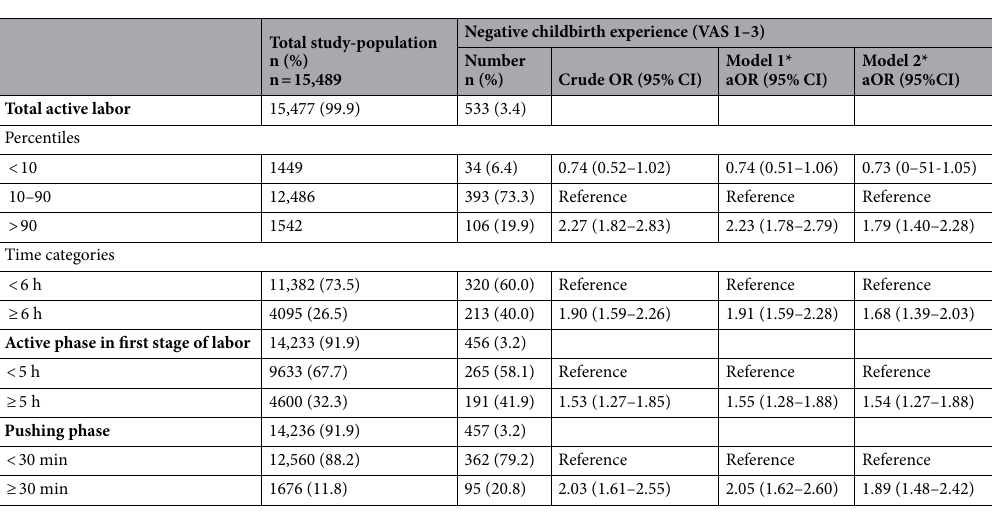
Table 4. Time in labor and risk of negative childbirth experience (VAS 1–3) in multiparous women. VAS visual analogue scale, h hours, min minutes, OR odds ratio, CI confidence interval. *Adjustments in. Model 1: maternal age, BMI and fetal birthweight. Model 2: maternal age, BMI, fetal birthweight, start of labor (spontaneous vs induction) and mode of delivery (vaginal birth vs cesarean